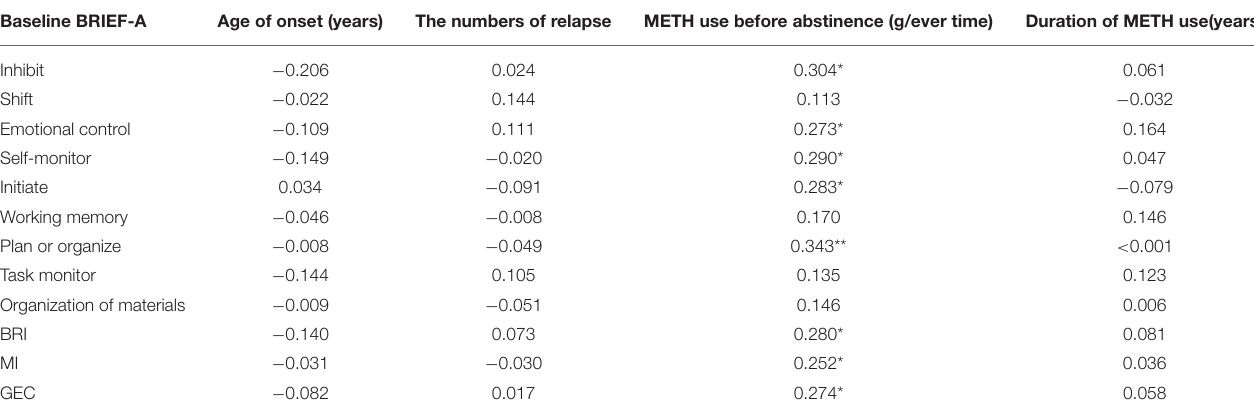
TABLE 2 | Baseline executive dysfunction was mainly related to METH use before abstinence ( N = 66). Baseline